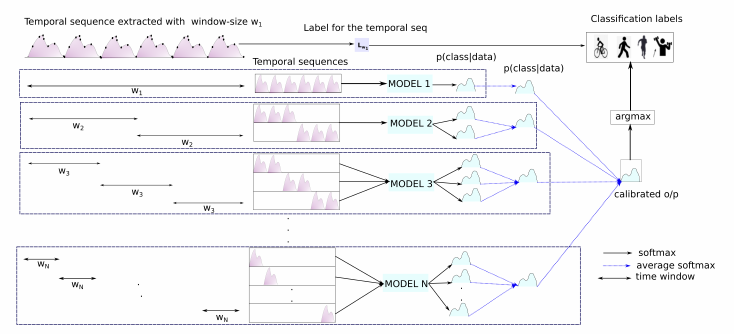
Figure 3. Magnified view of DTE evaluation for one temporal sequence.